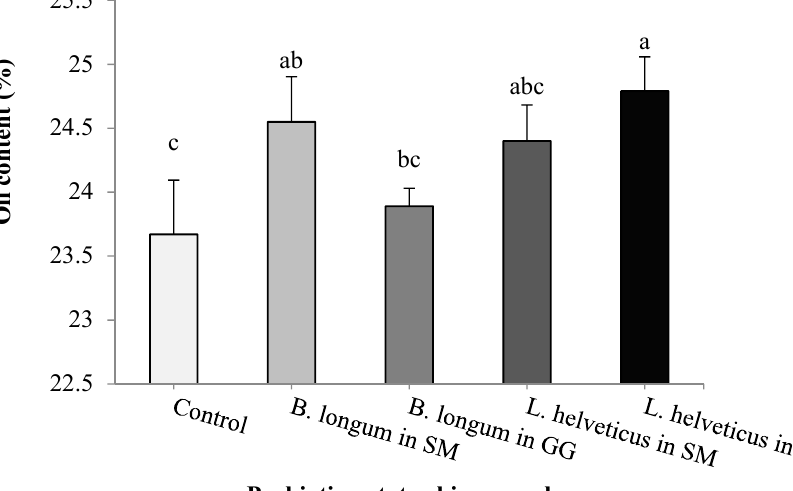
Figure 1. Oil content in di ff erent probiotic potato chips samples. Potato chips containing probiotic Bifidobacterium longum and Lactobacillus helveticus (lyophilized in skim milk or gelatin / glycerol medium) or without LAB (control), were analyzed after storage at 30 ◦ C for 4 months. a–d Di ff erent letters in the columns di ff er significantly ( p <